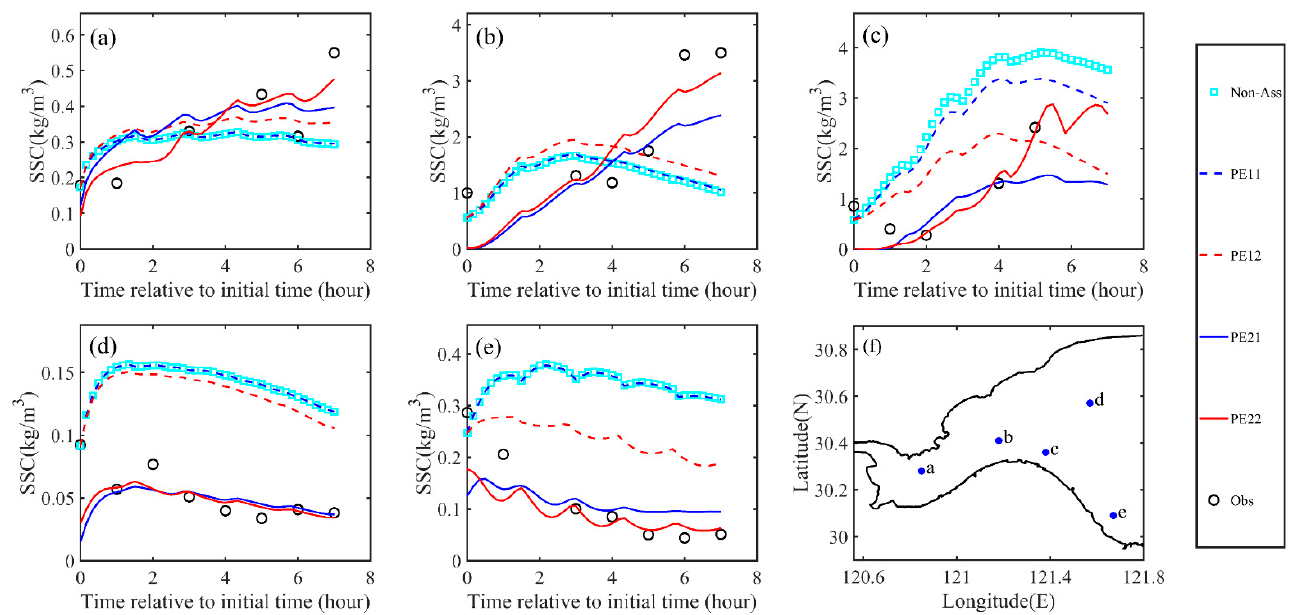
Figure 8. Variation of surface SSCs over time at ( a ) point a, ( b ) point b, ( c ) point c, ( d ) point d and ( e ) point e: observations (black circles), unassimilated results (cyan squares), PE11 (blue dashed line), PE12 (red dashed line), PE21 (blue solid line) and PE22 (red solid line); ( f ) Locations of the five randomly selected points.